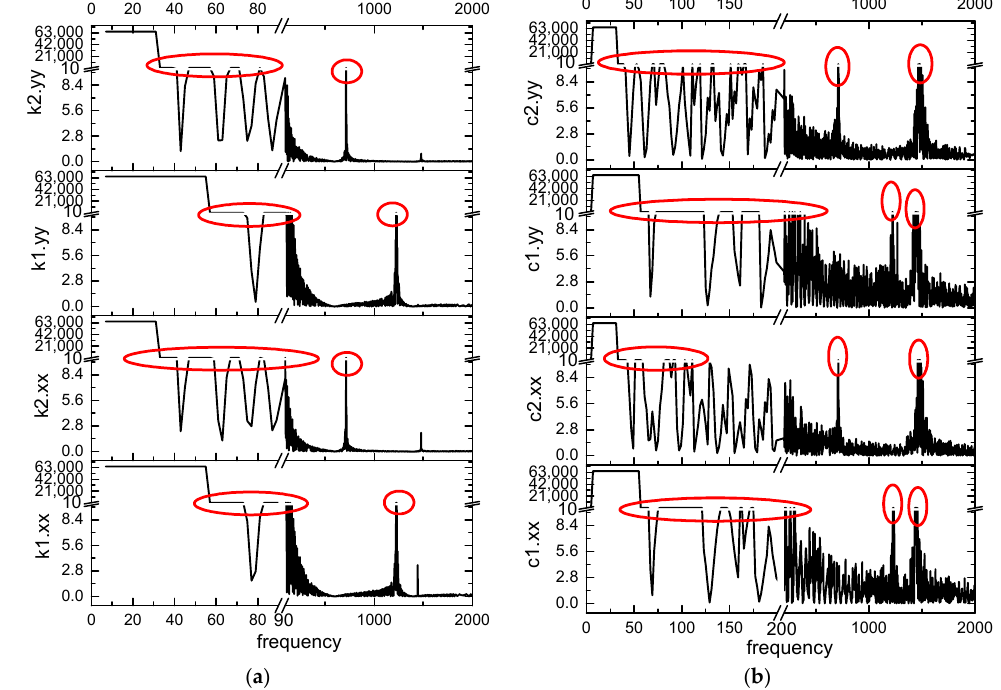
Figure A7. Identified bearing coefficients changing with frequency of g1.1 based on algorithm I considering adjustment point and sensor resolution 1 um: ( a ) obtained main stiffness coefficients in x and y directions; ( b ) obtained main damping coefficients in x and y directions.